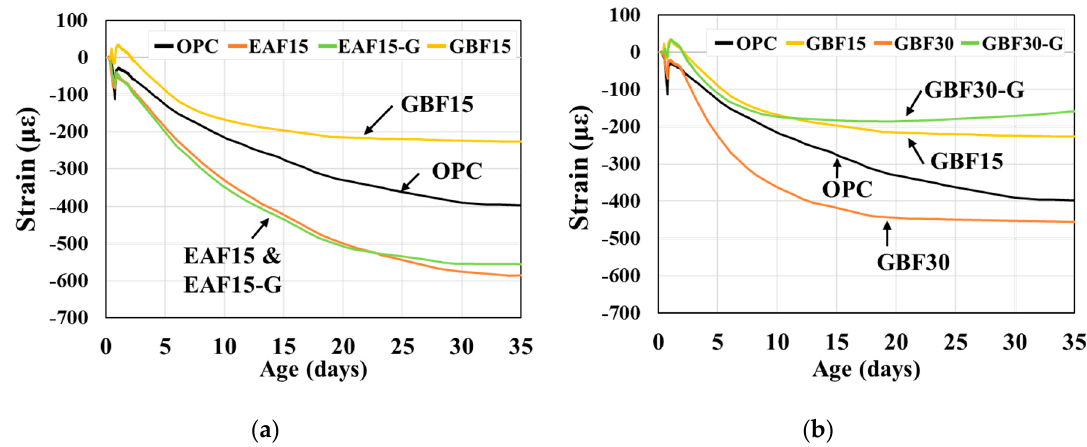
Figure 4. Results of drying shrinkage. ( a ) Results of EAF series and ( b ) results of GBF series.